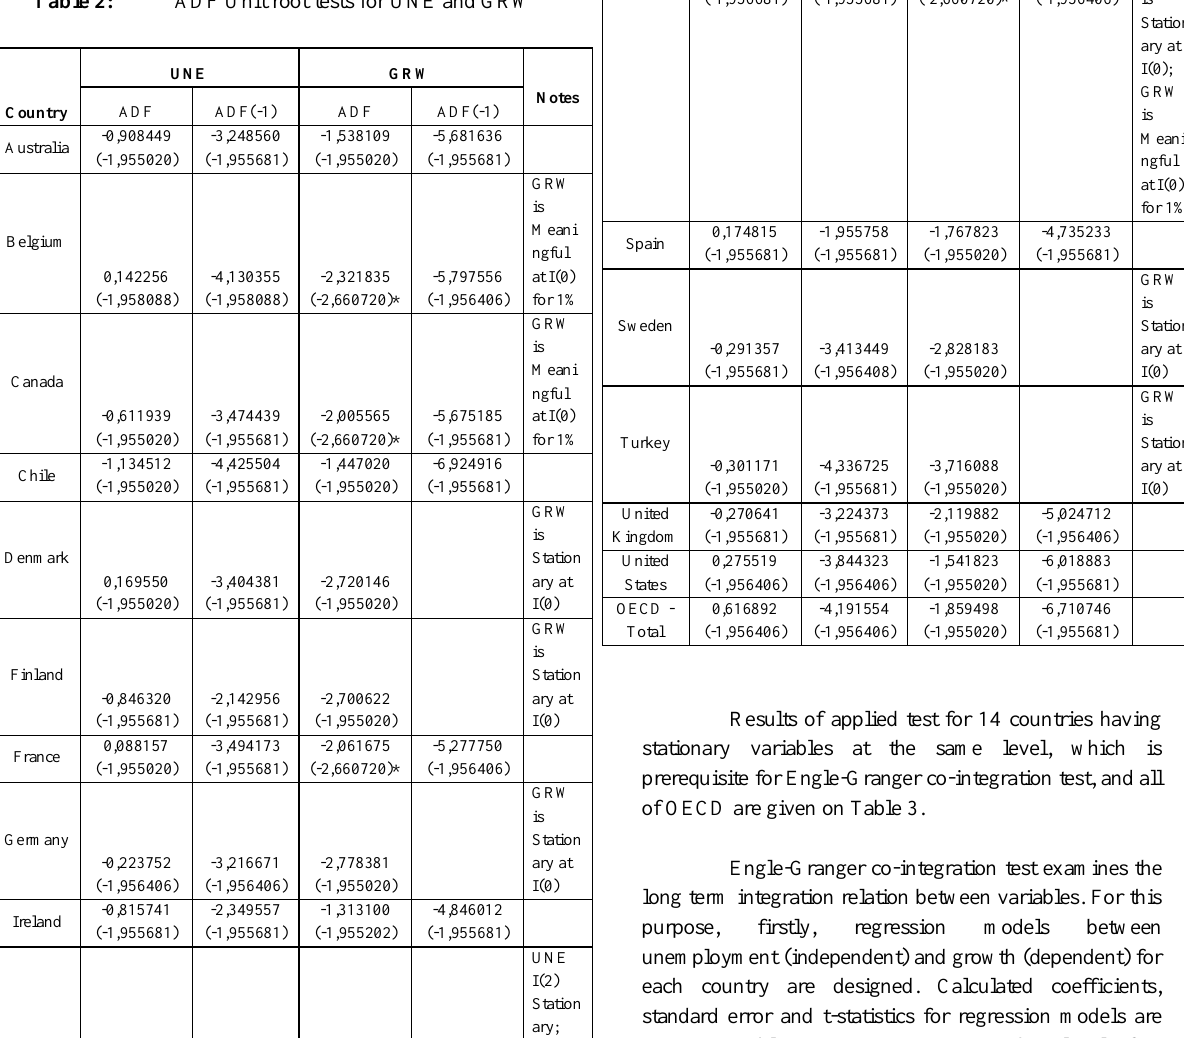
ADF Unit root tests for UNE and GRW